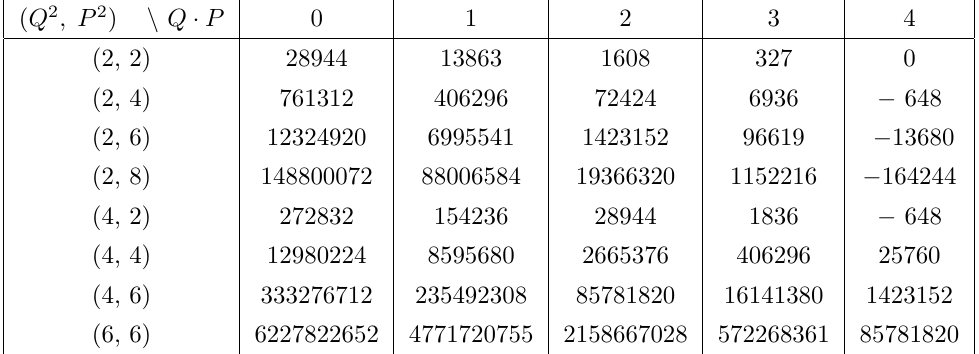
Table 4 . Index of horizon states for K 3 × T 2 , note that negative numbers have zero or negative values for Q 2 P 2 − ( Q · P ) 2